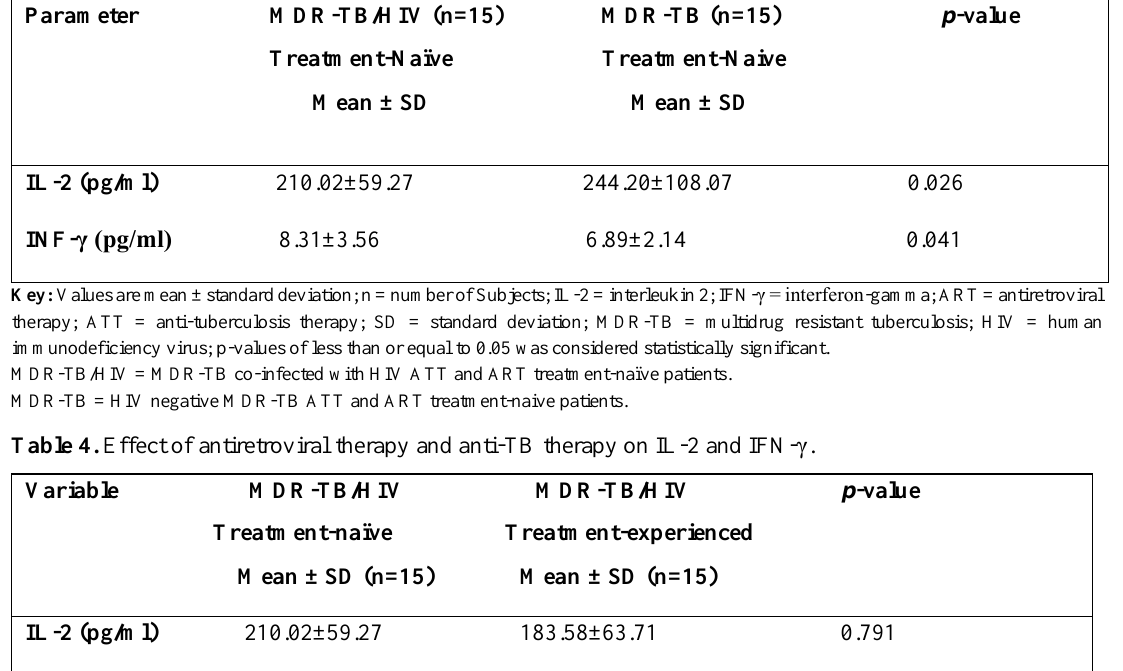
Table 3. Effect of HIV on plasma level of IL-2 and IFN-γ on MDR-TB.